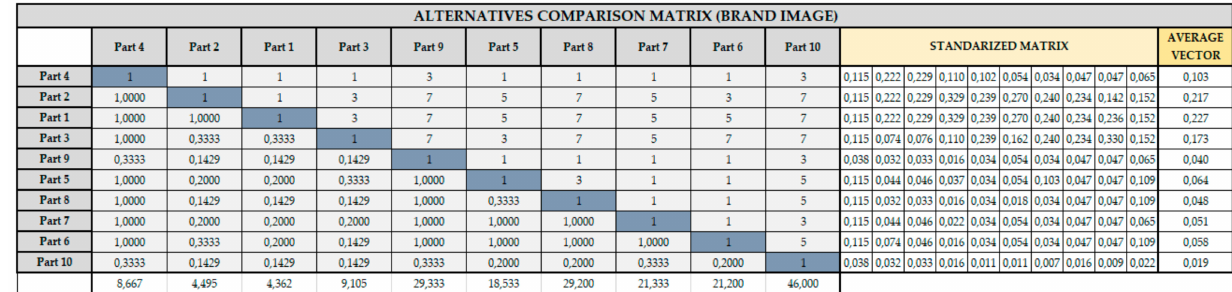
Figure 4. Example of alternative comparison matrix (brand image).